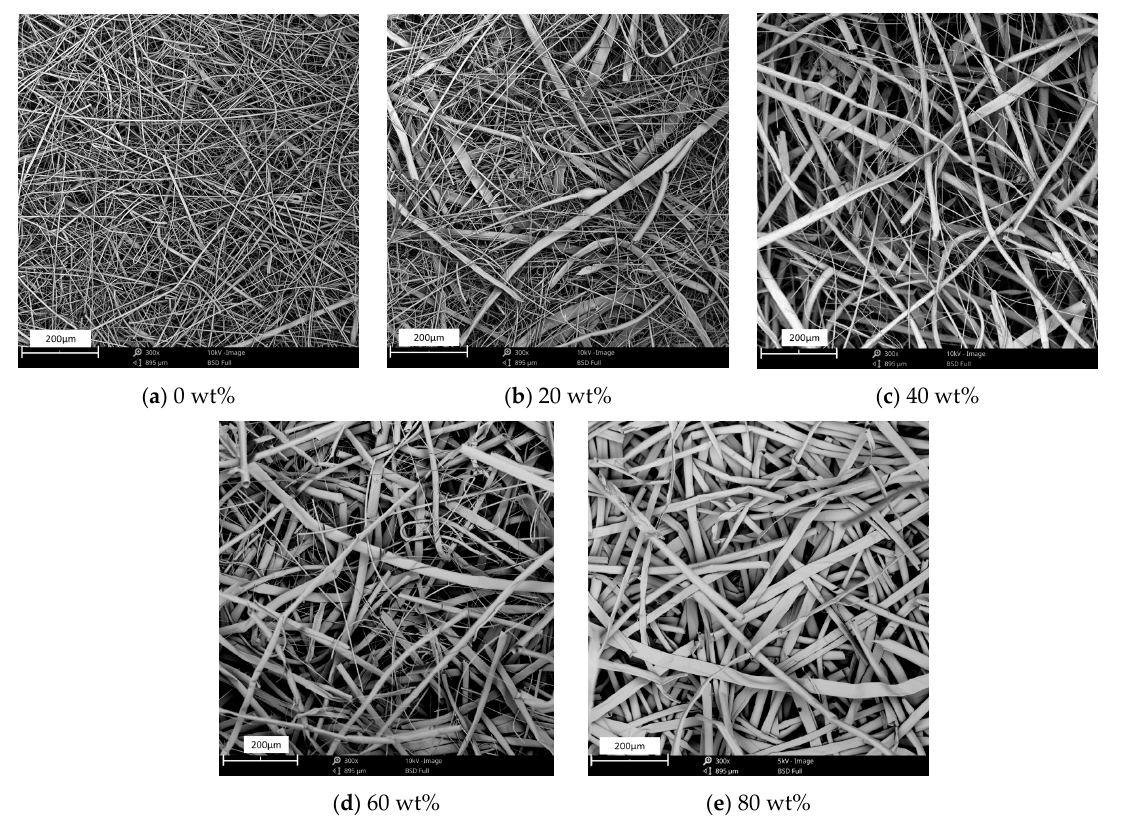
Figure 6. SEM images of filter media with different kapok fiber content.